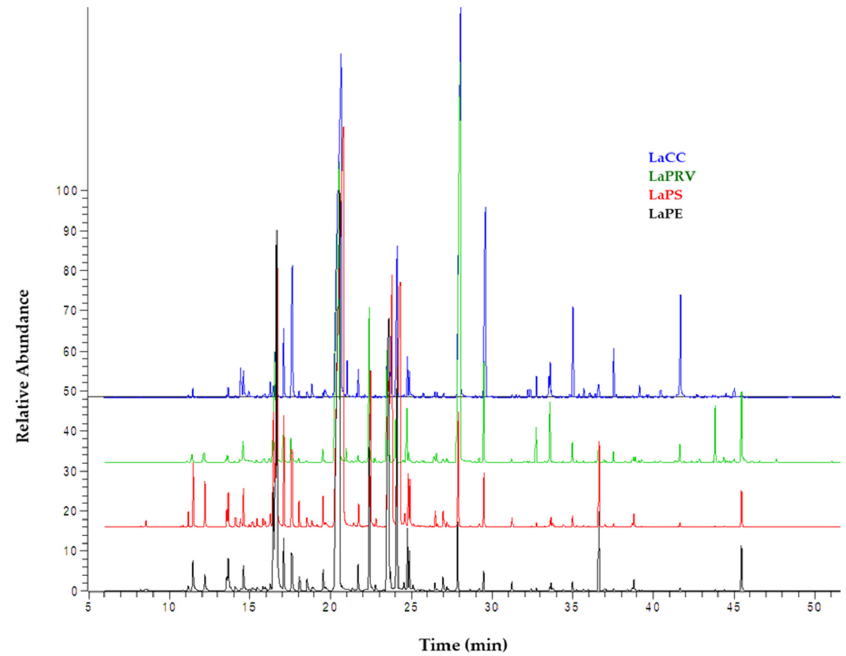
Figure 1. The GC-MS TIC chromatograms of lavender EO samples.